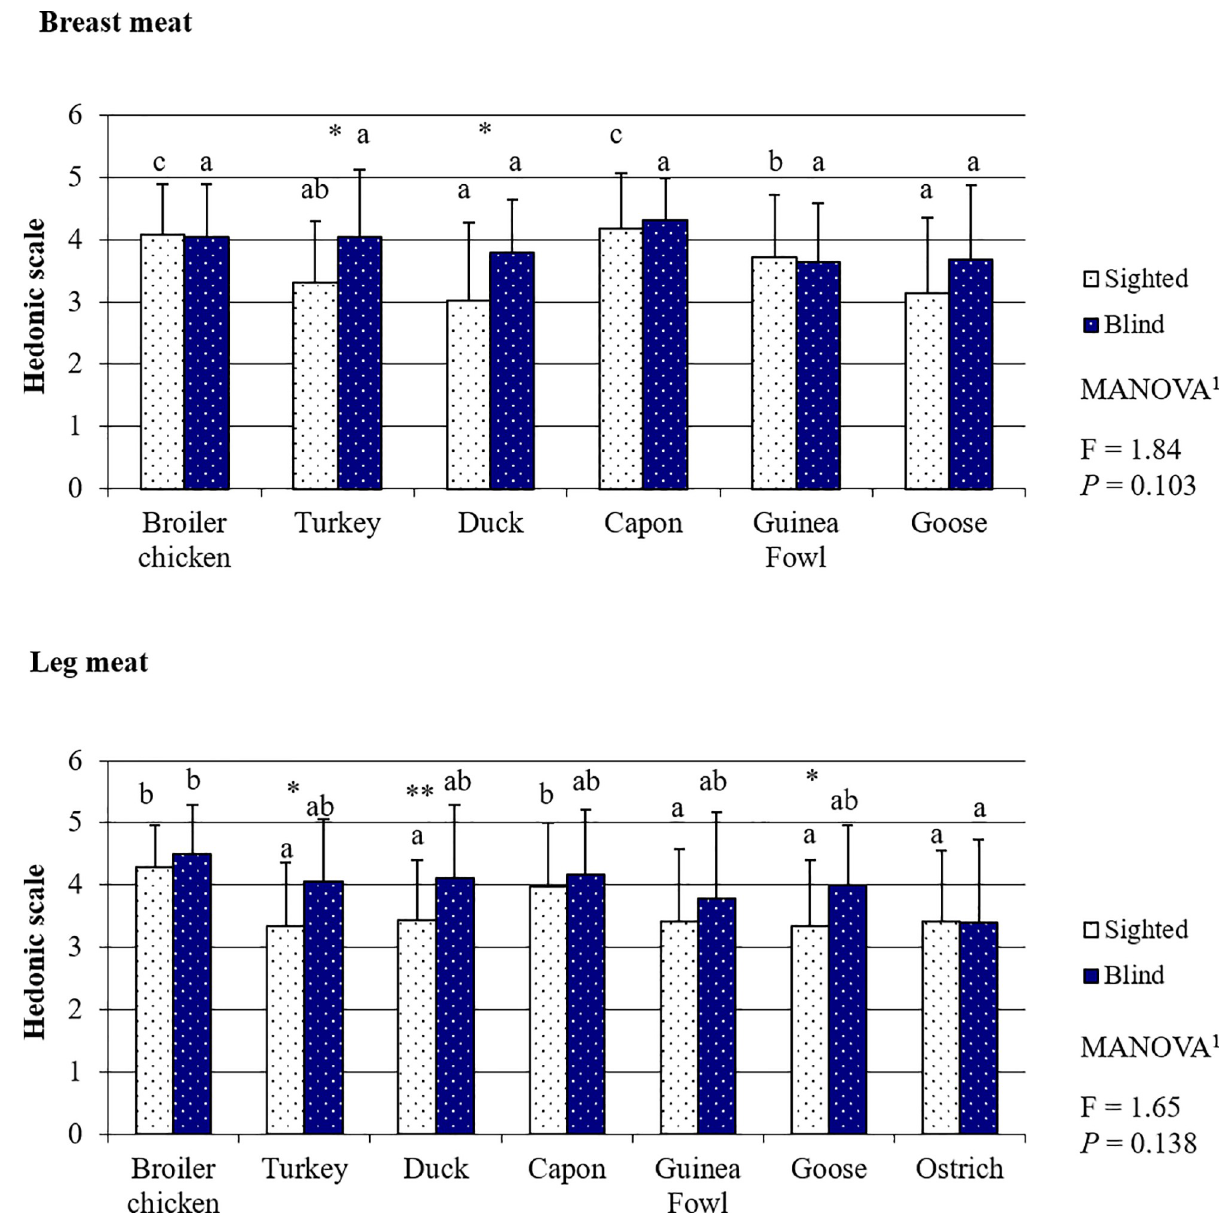
Fig 3. Poultry meat taste based on the evaluation by the sighted and blind panelists. Poultry meat taste evaluated by the sighted and blind panelists As for color and aroma, the most attractive meats to the sighted panelist in terms of taste (Fig 3, S3 Table) were BM and LM from capon and broiler chicken (all meats P < 0.05), whose scores did not differ significantly (BM P = 0.075; LM P = 0.059). The taste of LM from other bird species was assessed by the panelists as being similar ( P > 0.05), whereas in terms of BM, goose and duck meat was scored significantly lower compared to the meat from Guinea fowl (duck P = 0.022; goose P = 0.037). In contrast to the sighted panelists, the blind consumers assessed the taste of BM from all poultry species at a similar level. In the opinion of the blind